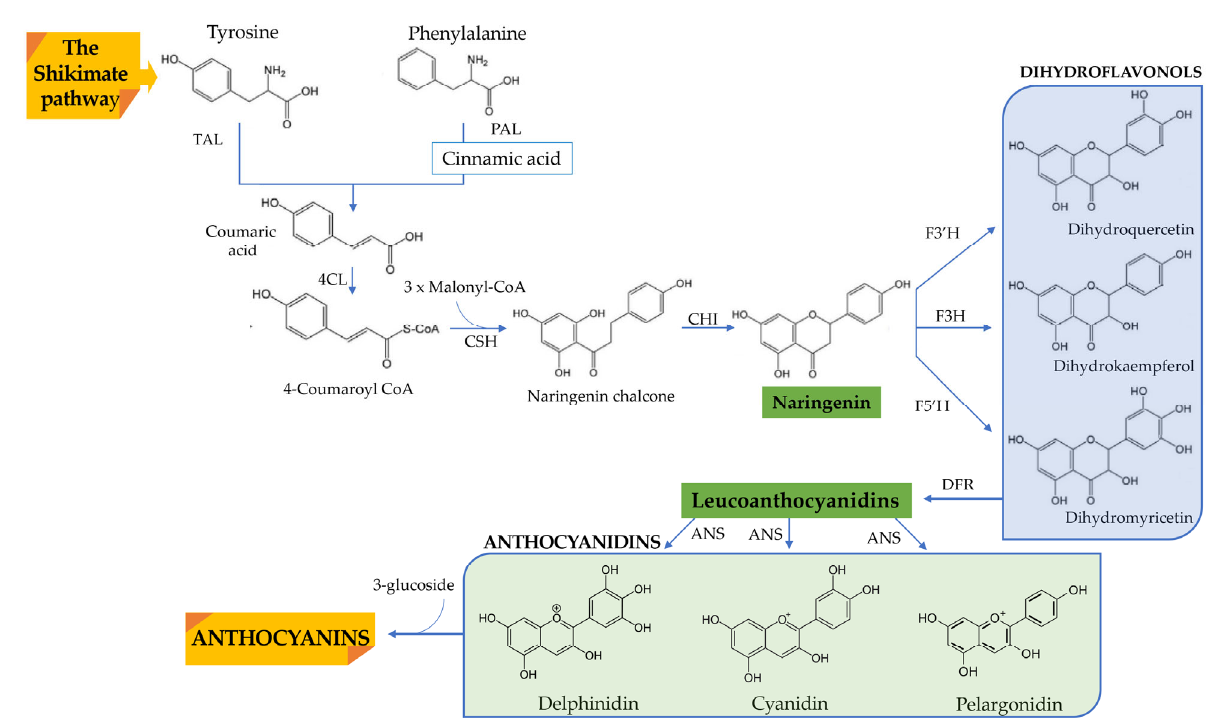
Figure 2. Overview of ACNs biosynthesis pathway (adapted from Zhang et al. [33], Liu et. al. [34] and Cruz, Basilio, Mateus, de Freitas and Pina [20]). 4CL: 4 ‐ coumaroyl ‐ CoA ligase; ANS: antho ‐